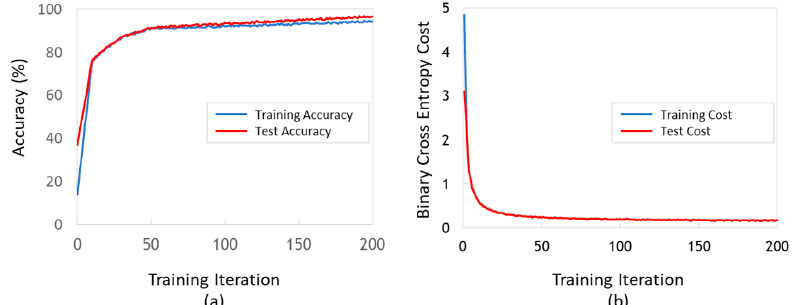
Figure 6. Accuracy and cost of training and testing using the first dataset: ( a ) accuracies of training (blue line) and test (red line); and ( b ) binary cross-entropy cost between ground truth and predicted labels for both training (blue line) and test (red line).